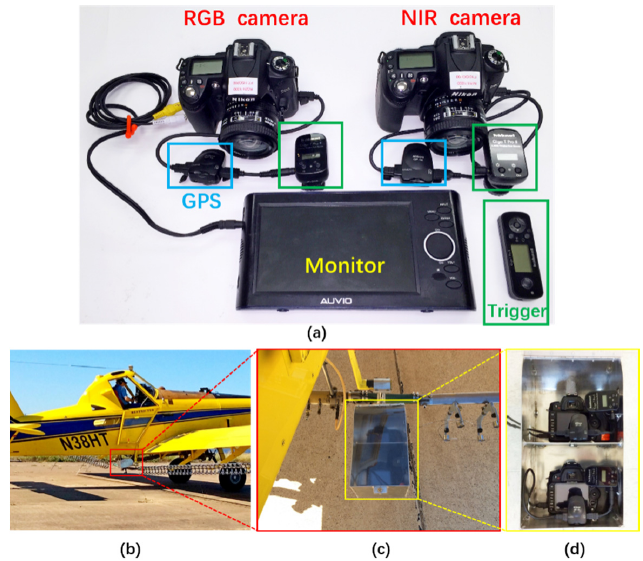
Figure 2. Imaging system and platform: ( a ) Components of the imaging system (two Nikon D90 cameras with Nikkor 24 mm lenses, two Nikon GP-1A GPS receiver, a 7-inch portable LCD video monitor, a wireless remote shutter release); ( b ) cameras mounted on the right step of an Air Tractor AT-402B; ( c ) close-up picture showing the custom-made camera box; and ( d ) close-up picture of the cameras in the box.